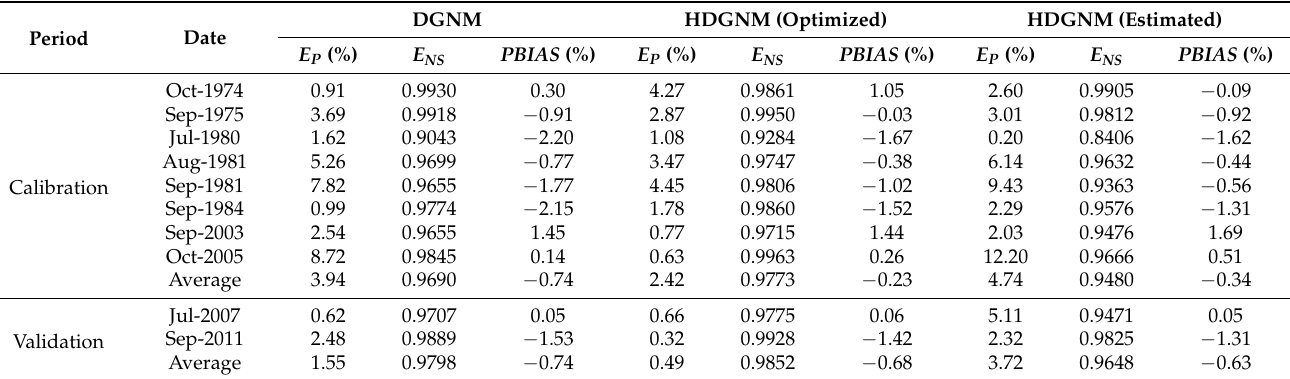
Table 1. Accuracy evaluation results of DGNM and